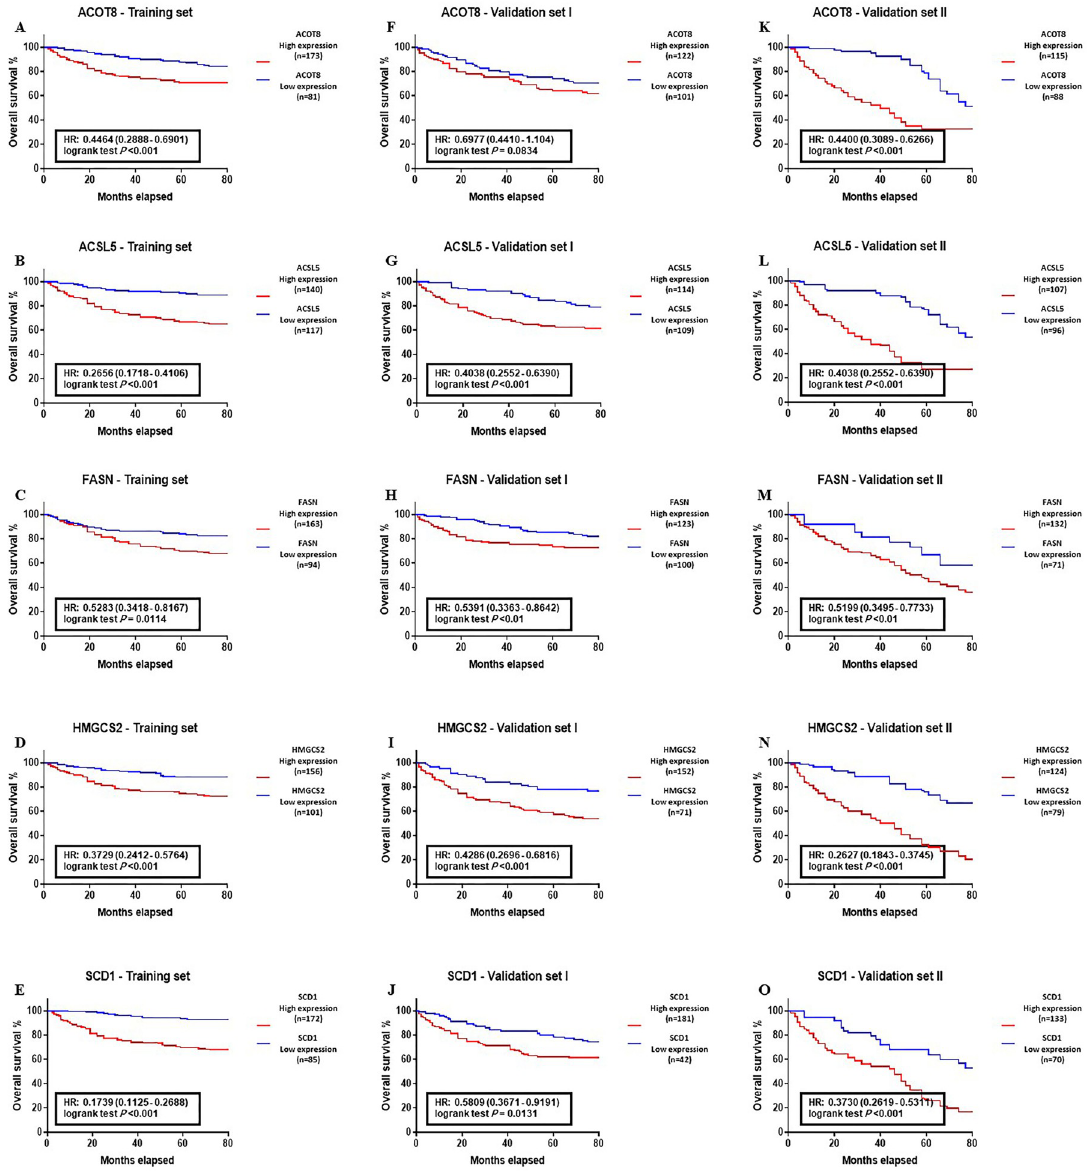
Fig 4. Correlation between the abnormal expression of ACOT8, ACSL5, FASN, HMGCS2, and SCD1 genes and overall survival (OS) of colon cancer patients. (A-E) Training group, (F-J) Validation I group, and (L-O) Validation II group. Kaplan-Meier analysis indicated a reverse correlation between individual genes upregulation and poor survival of CRC patients. (Training group n = 257, Validation group I n = 223, Validation group II n = 203.